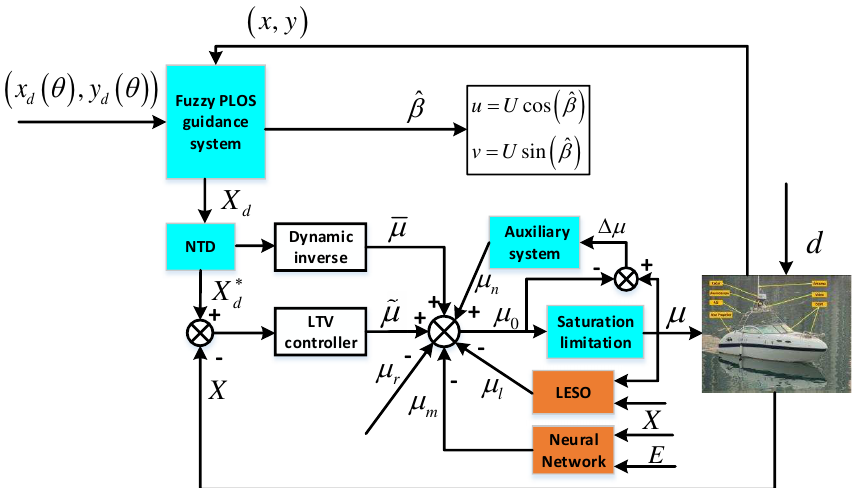
Figure 3. The block diagram of the proposed control strategy for the